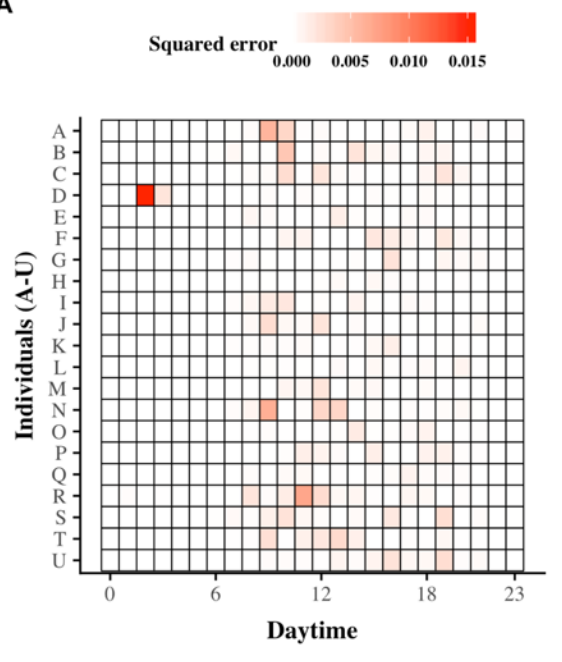
Figure 3. Goodness of fit of Gaussian mixture models (GMMs). Panel A corresponds to a heat map that figures out the squared errors calculated between empirical observations and their corresponding GMMs. Each line corresponds to one older individual, whereas columns correspond to hours of the day. Hence, the squared error between the outgoing telephone call activity and the estimated model at a given hour is represented by a colored cell that is all the more bright as the error increases. Panel B displays the associated goodness of fit by giving P values from the Kolmogorov-Smirnov comparison tests. Here, the significance threshold is set at .05 (dashed